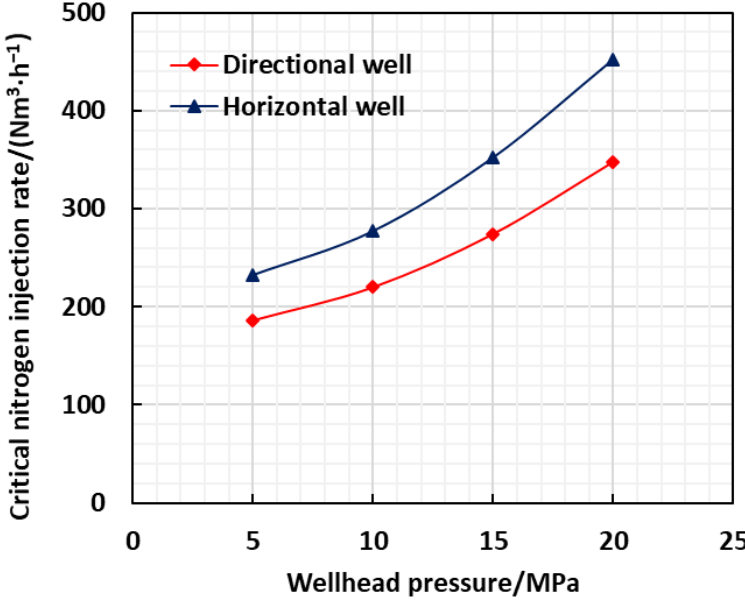
Figure 2. Relationship between wellhead pressure and critical nitrogen injection displacement.